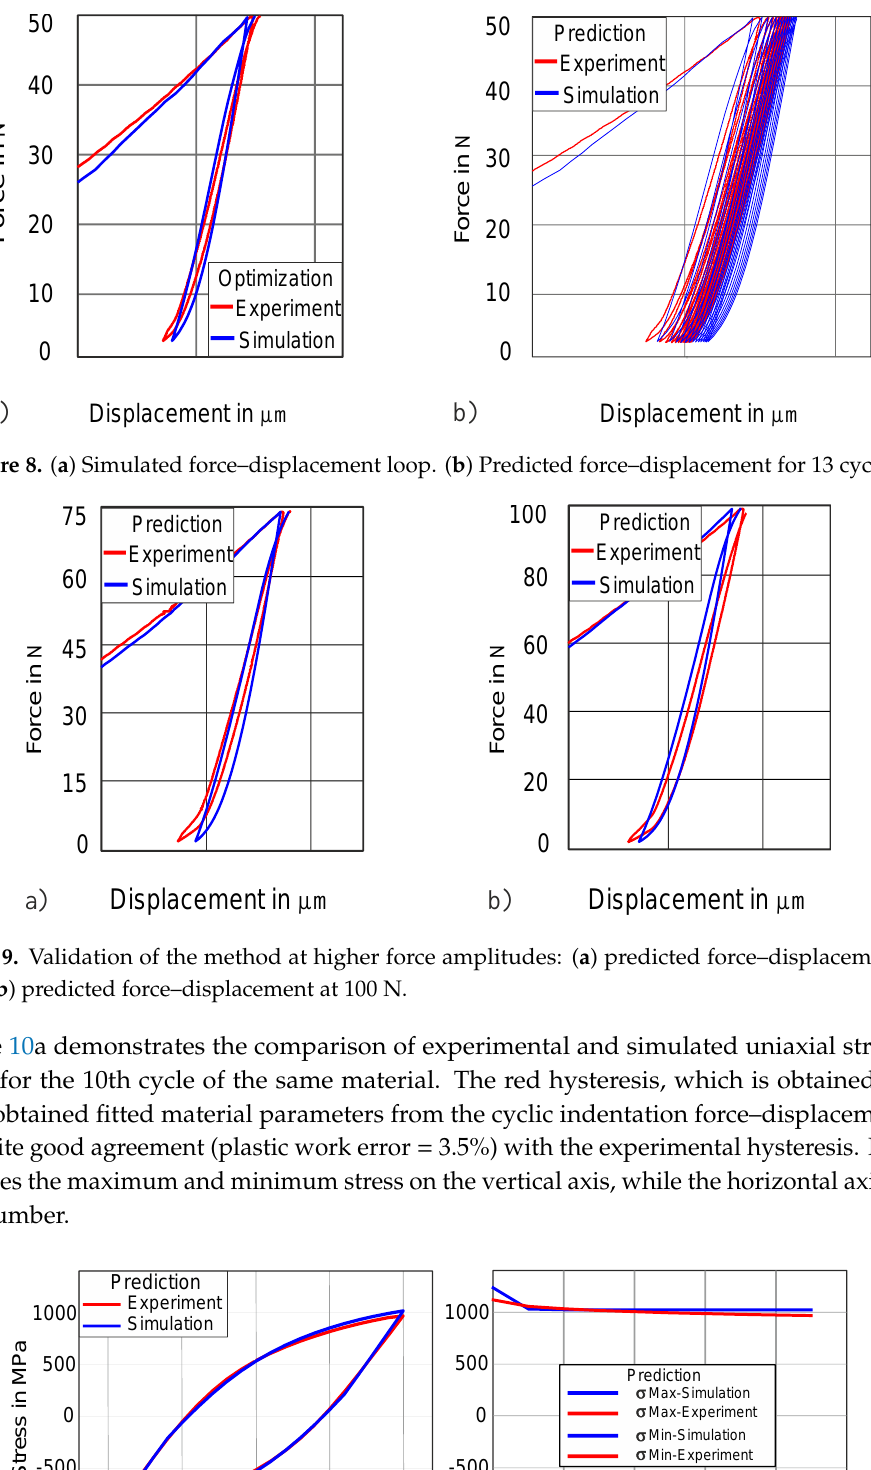
Figure 10. ( a ) Predicted uniaxial stress – strain hysteresis for the 10th cycle. ( b ) Stress amplitude over the number of cycles for the first 10 cycles.